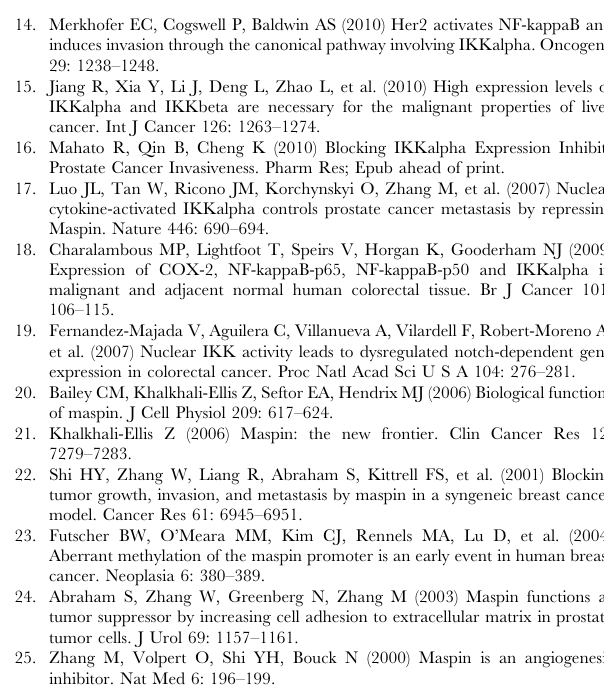
Figure S1 Graphical representation of the number of tumors developed in WT and Tg-K5-IKK a mice in the two skin carcinogenesis approaches. ( A ) K5-IKK a and WT 9-week-old mice (9 animals respectively) were subjected to DMBA/TPA carcinogenesis assay. Tumors were traced until week 26, when they were collected. ( B ) Double transgenic K5-IKK a -TgAC and WT-TgAC 9-week-old mice (11 animals respectively) were treated twice weekly with topical applications of TPA. Tumors were traced until week 30, when they were collected. No differences were found between number of tumors developed in WT and Tg animals in both